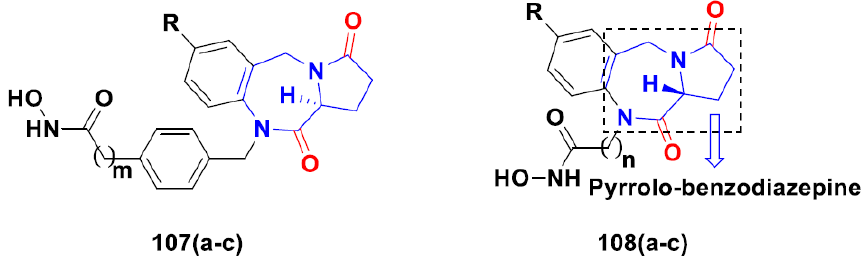
Figure 102. Structure of pyrrolo-benzodiazepine-dione derivatives [ 107 ( a – c ), 108 ( a – c )]. Table 91. In vitro cytotoxic activities of pyrrolo ‐ benzodiazepine ‐ dione hybrid compounds [ 107 ( a – c ), 108 ( a – c )].